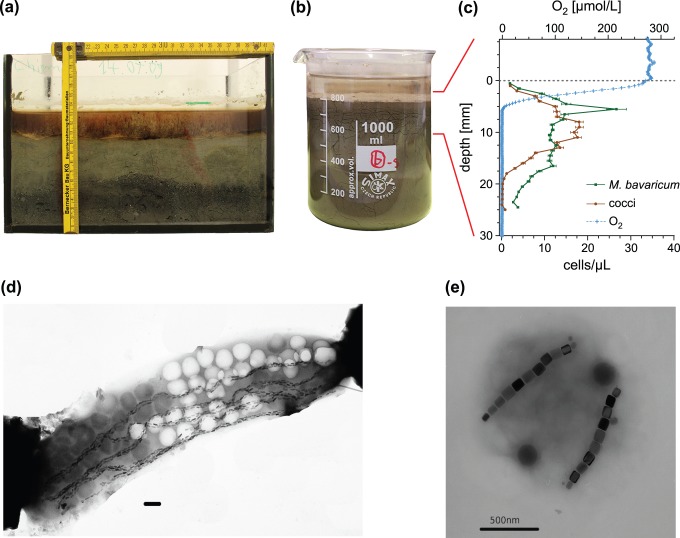
Microcosms and MTB characterization.(A) 30×20×20 cm glass aquarium filled with sediment. (B) 1 L sediment microcosm. (C) Oxygen profile measured after 7 days stabilization, and mean MTB profiles obtained from the average of  minicores. Error bars correspond to , where  is the standard error estimated from the standard deviation σ of n individual minicore profiles. (D) Transmission electron micrograph (TEM) image of M. bavaricum containing five bundles of tooth-shaped magnetosomes and several empty (light) and filled (dark) sulfur inclusions. The horizontal bar corresponds to 0.5 µm. (E) TEM image of a coccus containing two chains of prismatic magnetosomes. The horizontal bar corresponds to 0.5 µm.